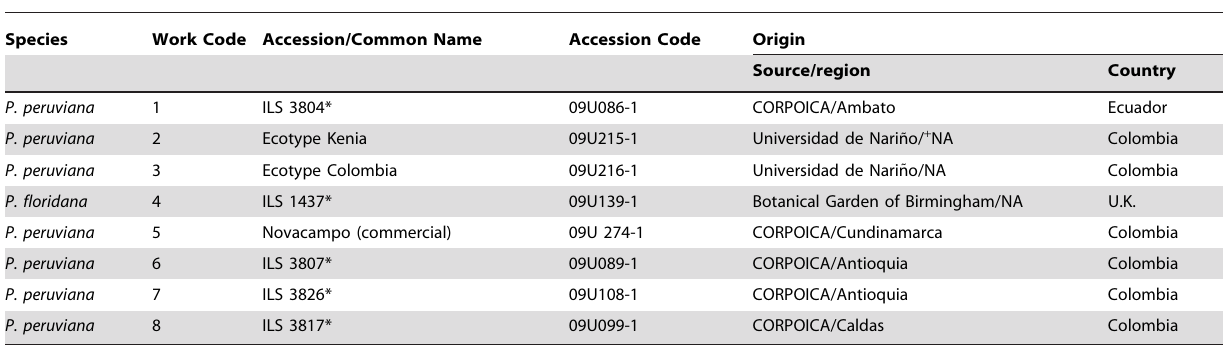
Table 1. Plant material used for SSR development and characterization.